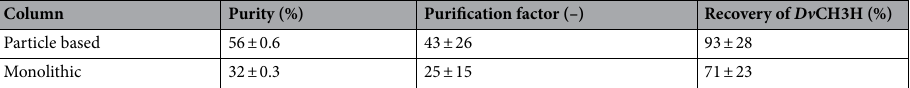
Table 2. Comparison of the IMAC purification on a monolithic and particle-based column.